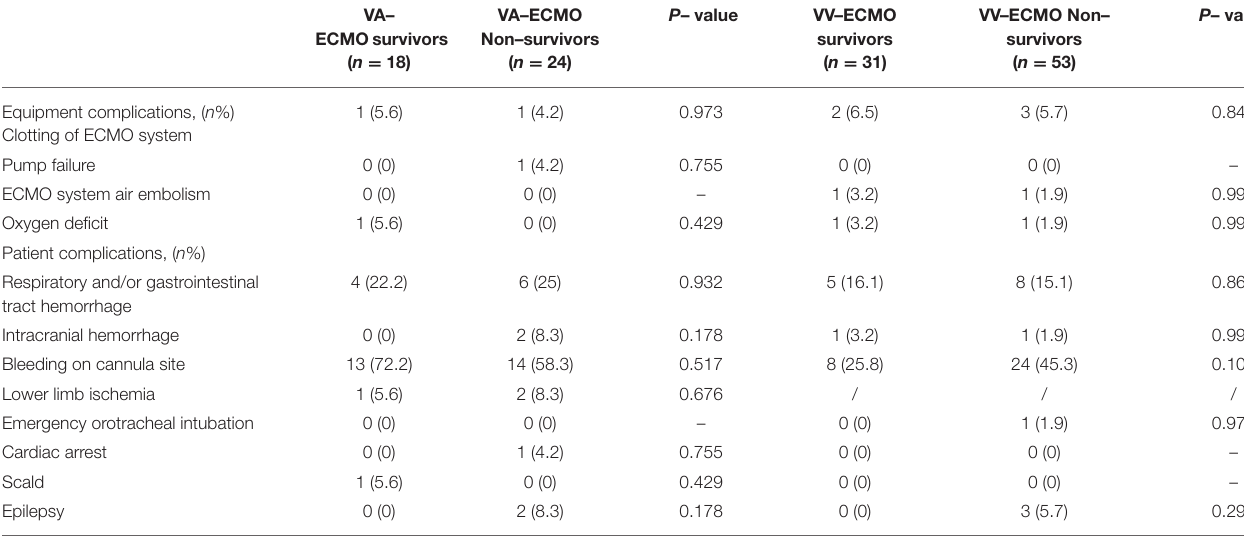
TABLE 3 | Comparison of the complications of the survivors and non-survivors of VA-/VV-ECMO.